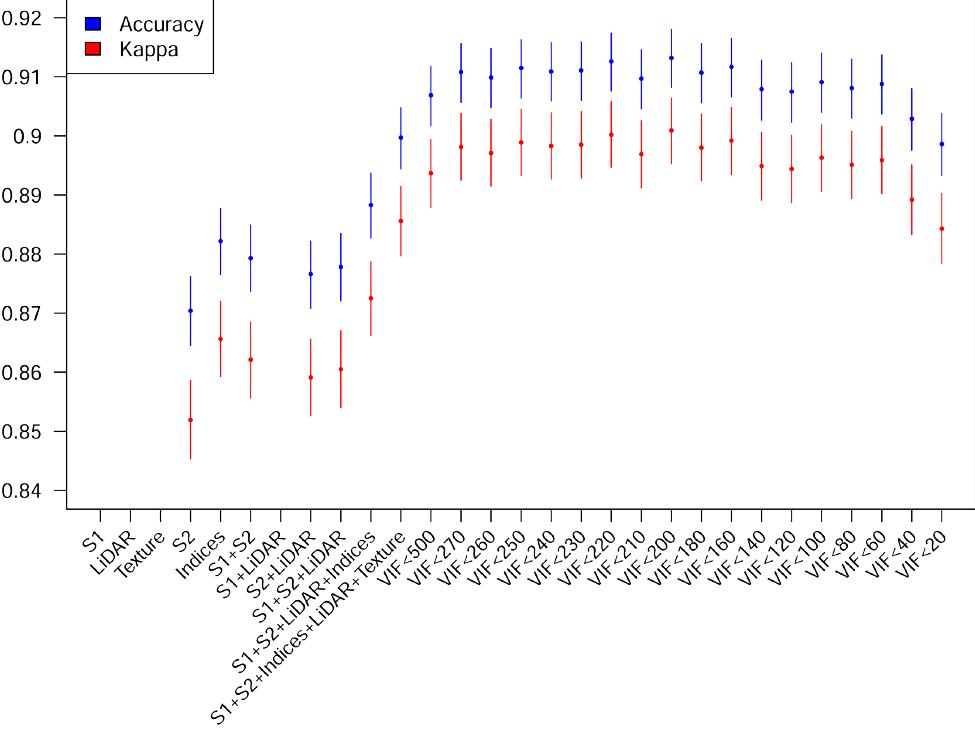
Figure 3. Accuracy metrics and 95% confidence intervals achieved with every dataset and with the predictors selected increasing the VIF threshold. S1, Texture and S1+LiDAR results do not appear because they are lower than the y axis lower limit in the